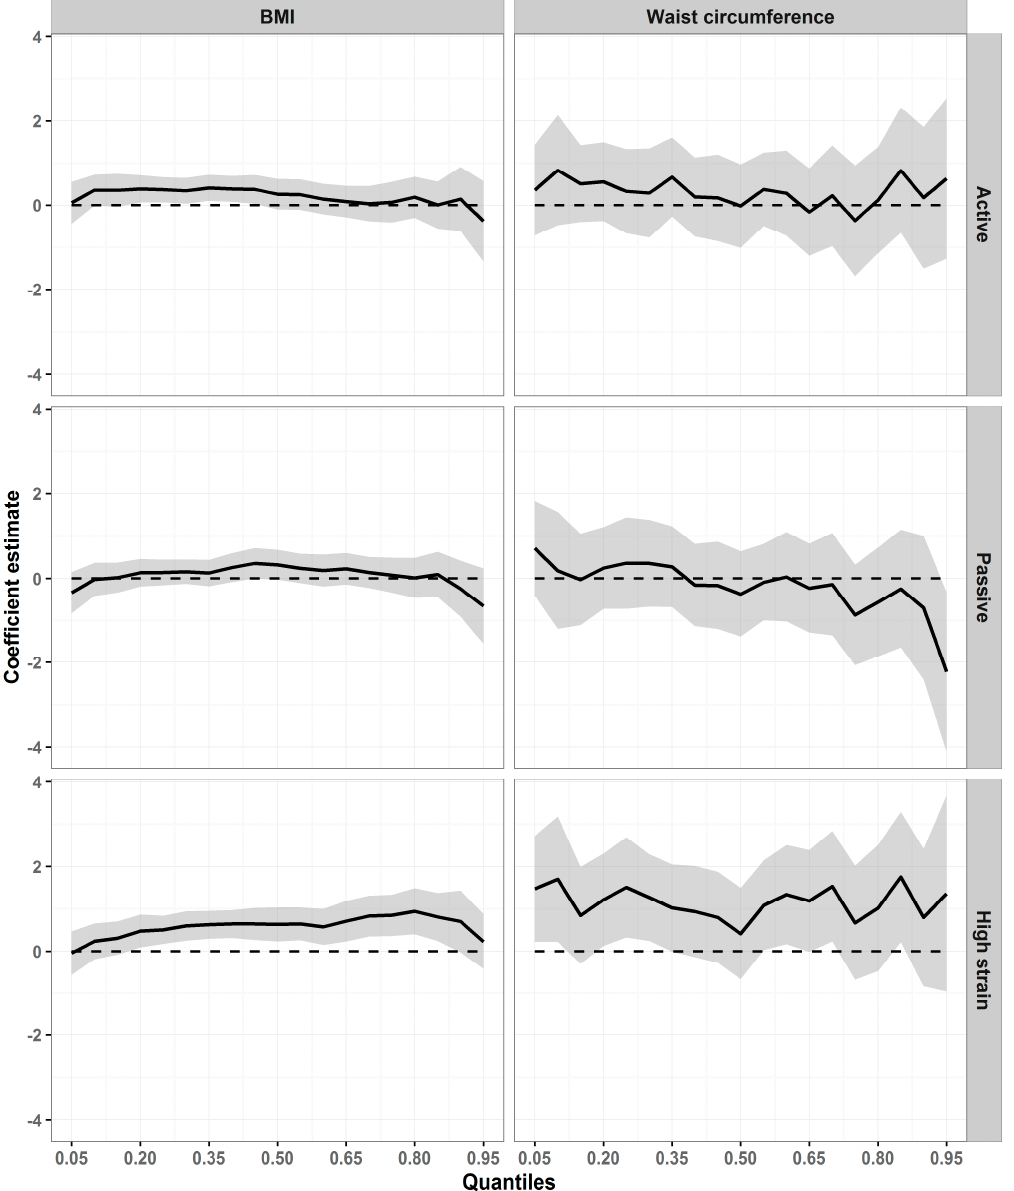
Figure 2. Association between job strain and adiposity (BMI and WC) in adjusted quantile regression models among men. ELSA-Brasil, 2008–2010 ( n = 5708). On the horizontal axes are the BMI and WC distribution percentiles; the vertical axes show the values of the coefficients estimated. The dashed parallel line represents the null value (zero), and a solid line stands for quantile estimates. The grey area surrounding the solid line represents the 95% CI for the quantile estimates. The coefficients are adjusted by age, marital status, and study center for BMI; and by age, marital status, schooling, hours worked weekly, and study center for WC.